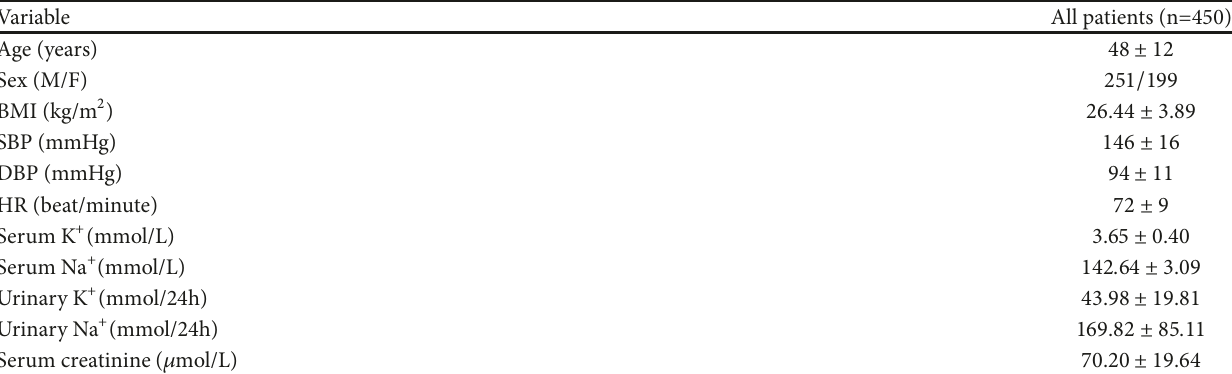
Table 1: Baseline characteristics of included hypertensive